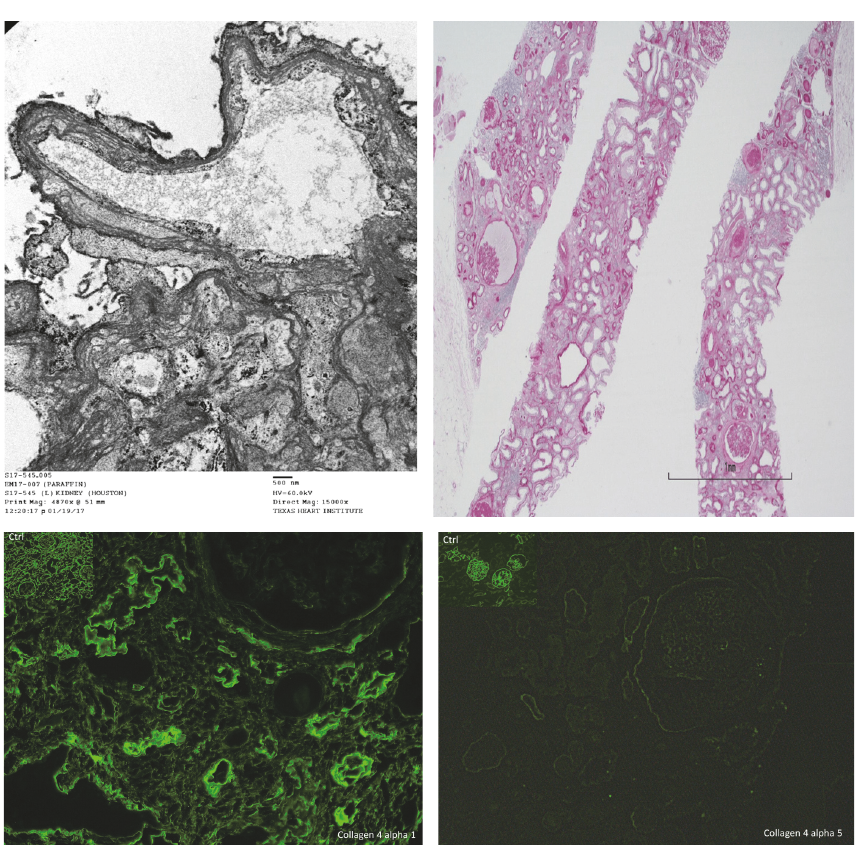
Figure 1: Kidney Biopsy . Electron microscopy identifying a split lamina densa (top left). Light microscopy demonstrating significant tubular atrophy and interstitial fibrosis (top right). Immunofluorescencehighlighting absent staining for the a5 chain of type 5 collagen in the patient and no immune deposits (bottom